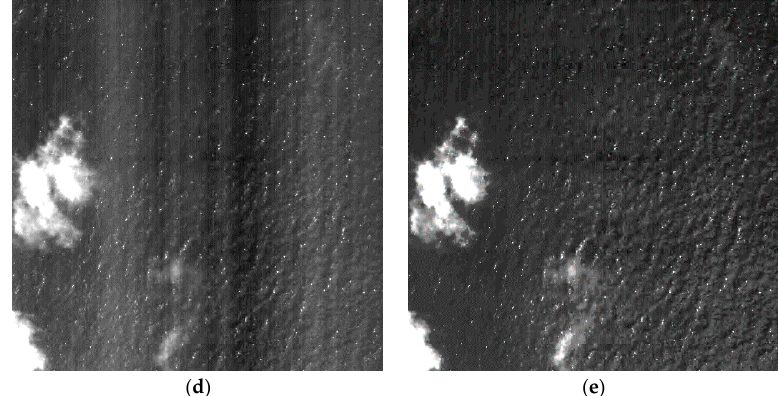
Figure 16. Raw and corrected images of water (the images are stretched for display): ( a ) raw image; ( b ) image corrected using the polynomial fitting; ( c ) image corrected using the laboratory coefficients; ( d ) image corrected using the on-orbit coefficients; ( e ) image corrected using the proposed method.